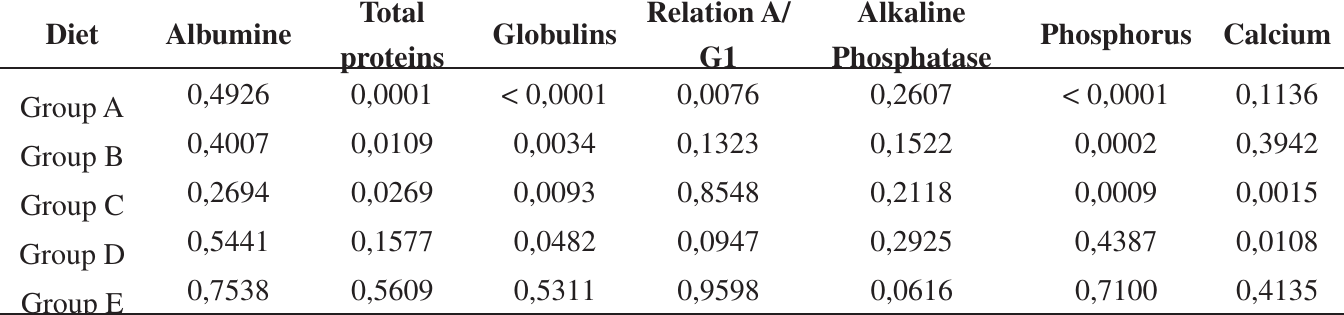
TABLE 2 – Value of p of the variance analysis for measures repeated to evaluate the effect of intervention (experimental groups x control) in laboratorial exams